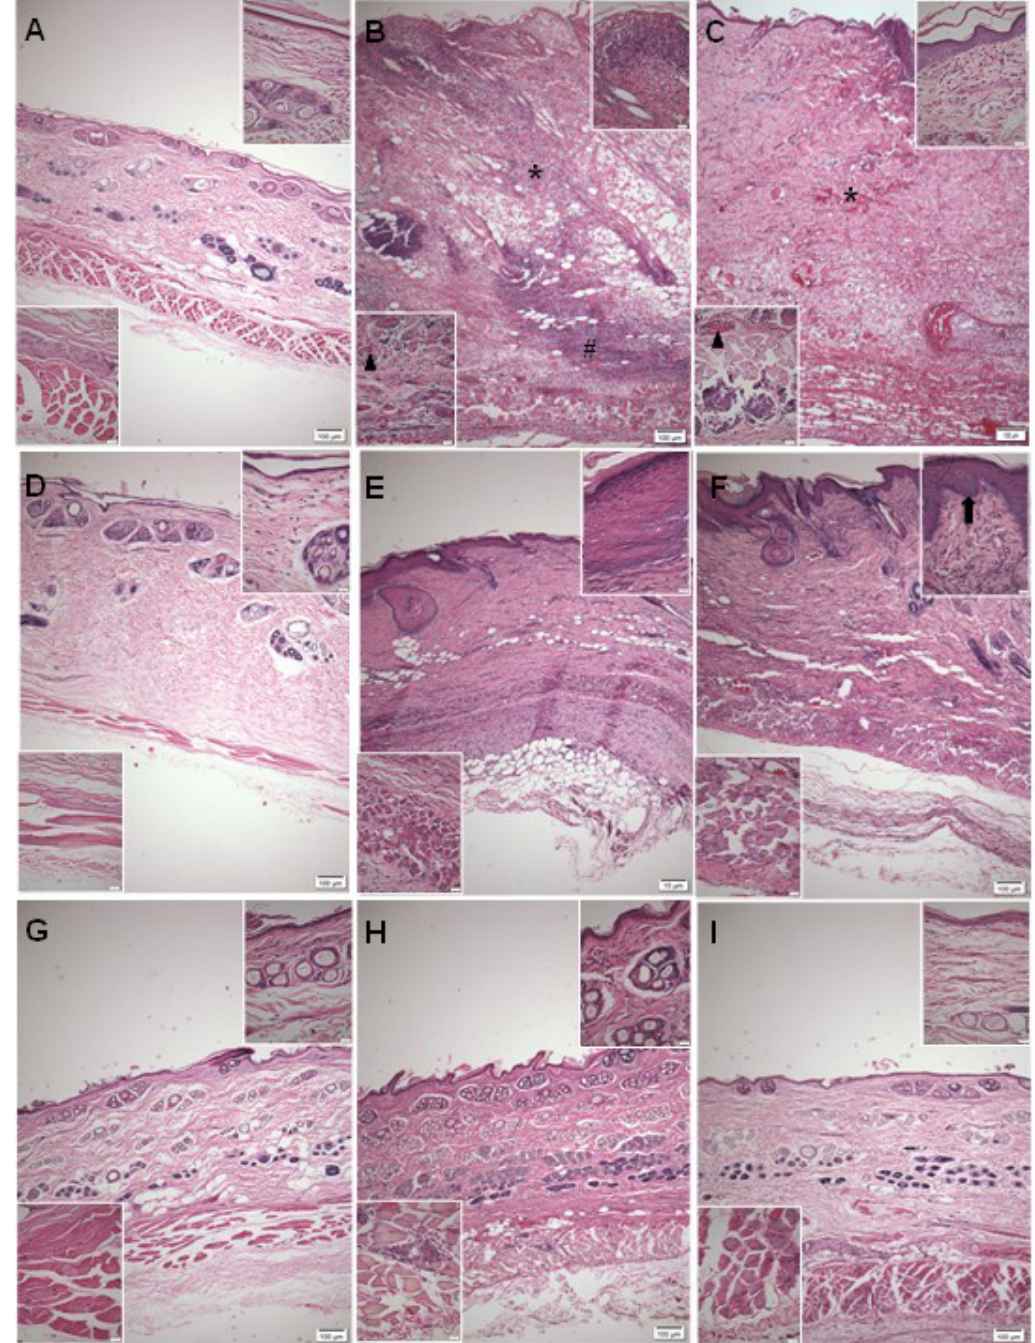
Figure 3. Photomicrographs of the skin of rabbits 3, 10 and 30 days after L. intermedia venom inoculation in the back. The control group presented integrity of the skin layers ( a/d/g ). In the animals that received venom injection (4.8 µg/kg) heavy bleeding in the dermis (*), epidermal thickening (upper insert - b ), the presence of intense inflammatory infiltrate in muscle (lower insert - b ) and hypodermis tissue (#) and blood vessels with clot ( ) were observed 3 days after inoculation (b) . In animals inoculated with venom and treated with copaiba oil, bleeding (*), injury of the epidermis (upper insert - c ) and inflammatory infiltrates in muscle tissue (lower insert - c ) were observed 3 days after venom inoculation ( c ). After 10 days, the dermal thickness was reduced in venom group ( e ), but the epidermis remained thick (upper insert - e ); on the other hand, in the treated group, dermal thickness was reduced ( f ), but redefinition was detected between papillary and reticular dermis (upper insert - f ). After 30 days of regeneration of the dermis, epidermis (upper insert - h ) and muscle tissue, marked by the presence of central nuclei (inferior insert - h ) after 30 days in the venom group ( h ); the treated group also showed regeneration of dermis, epidermis (upper insert - i ) and muscle tissue (lower insert - i ), marked by an increase in the number of hair follicles ( i ). n = 4 animals per experimental